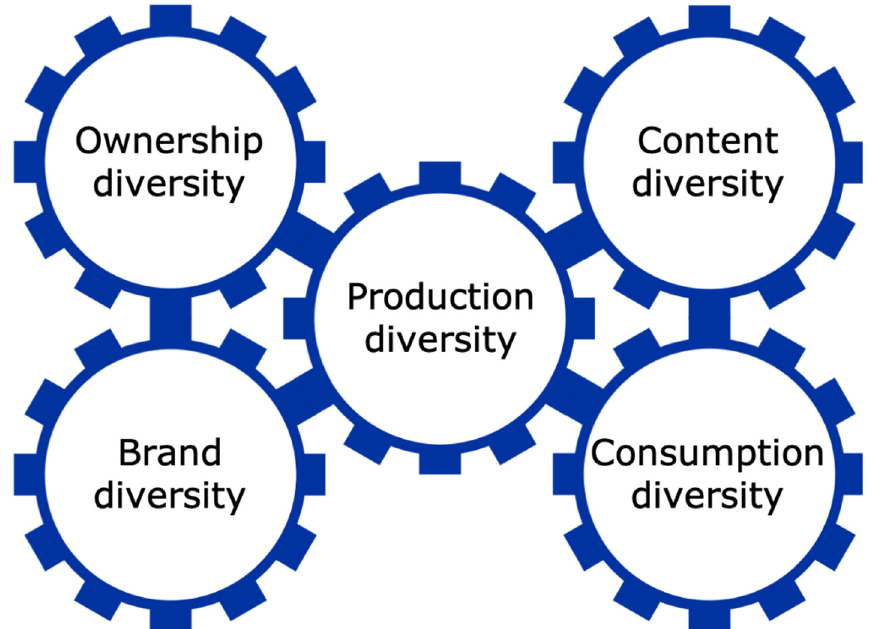
Figure 1. Model of news diversity (Hendrickx et al. 2020).